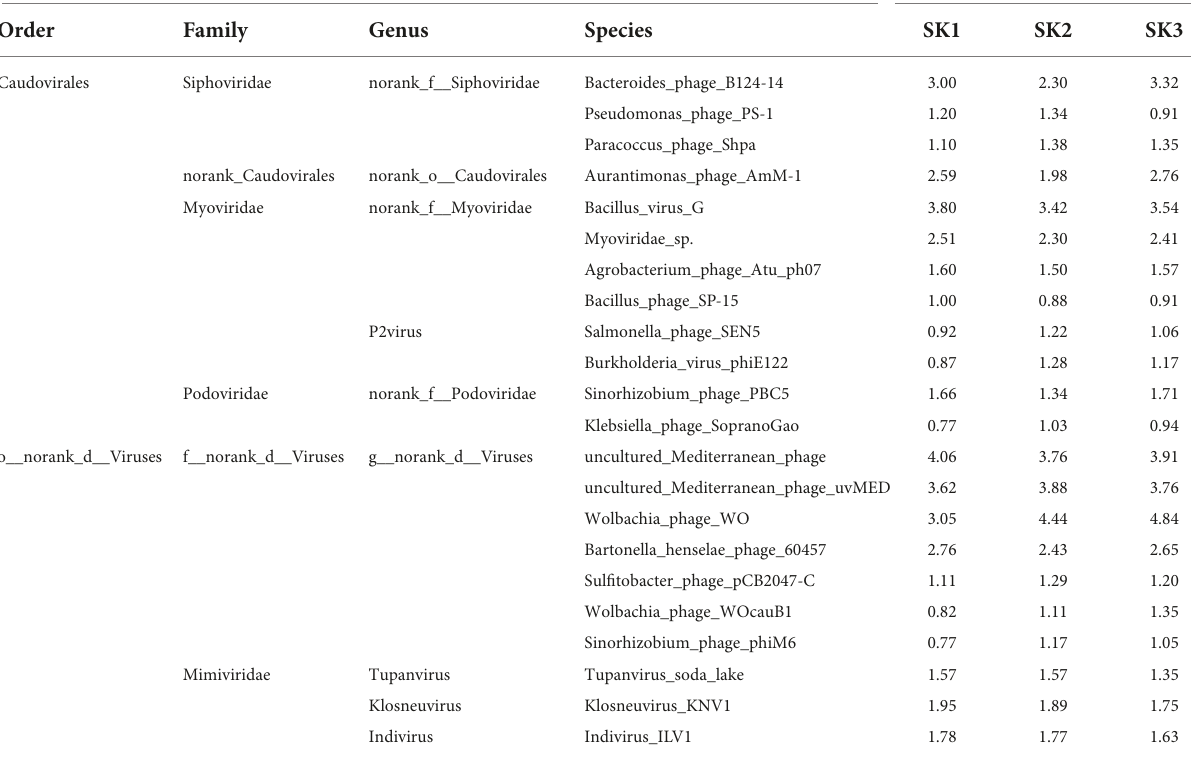
TABLE 5 Transcripts per million (TPM) abundance percentage of samples at the species